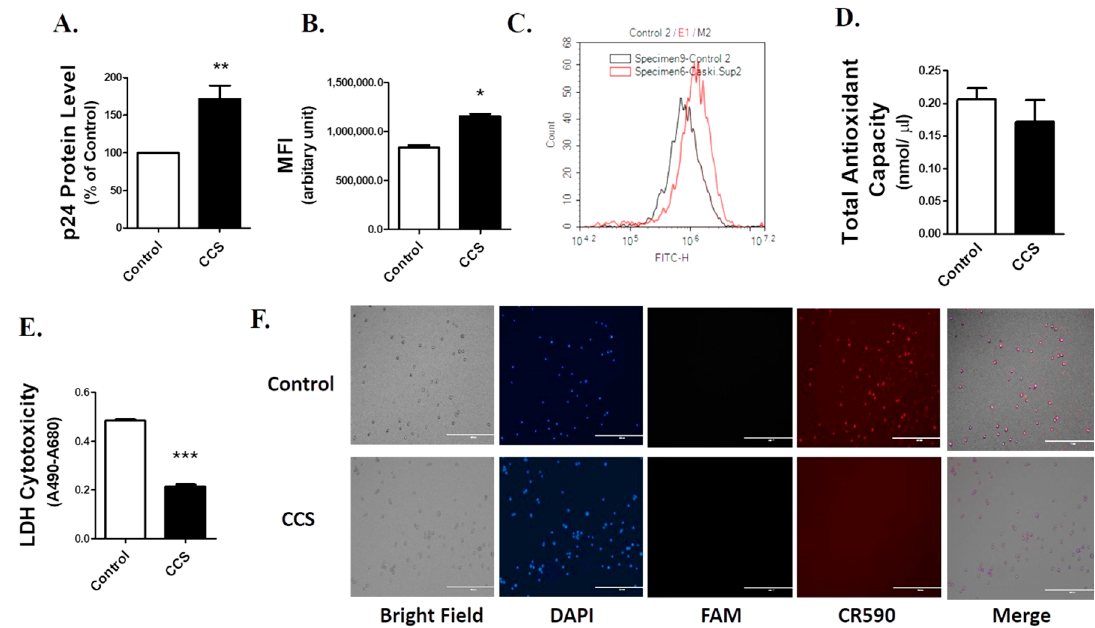
Figure 1. Caski cell culture supernatant (CCS) increases human immunodeficiency virus (HIV)-1 replication and oxidative stress in di ff erentiated U1 cell line. ( A ) Di ff erentiated U1 cell line was treated with 250 µ L of CCS every 24 h for 4 days. p24 ELISA was performed on the supernatant obtained from the treatment to measure the viral load. To minimize high standard deviation of the mean due to variability in absorbance values in di ff erent experiments, we converted the control absorbance values to 100% and normalized the values of treated groups to % of the control. ( B ) Reactive oxygen species (ROS) was measured in di ff erentiated U1 cell line after 4 days exposure of CCS. The treated cells were incubated with 2 (cid:48) ,7 (cid:48) - dichlorodihydrofluorescein diacetate (H2DCFDA), the fluorescence of which was monitored at maximum excitation and emission spectra of 495 nm and 529 nm, respectively, using flow cytometry. ( C ) Shows the graphical representation of ROS increase in CCS-treated U1 cells (red graph) versus control cells (grey graph). X-axis represents mean fluorescence intensity (MFI), showing ROS level. ( D ) Total antioxidant capacity of the cells was measured in CCS-treated cells using the Total Antioxidant Capacity Assay Kit. The values on the Y-axis represents the total amount of reduced Cu + in nmol / µ L, which quantitatively gives the measure of antioxidant capacity of the cells. ( E) Cytotoxicity after CCS exposure was measured using the Pierce TM LDH cytotoxicity assay kit. The values on the Y-axis represent the absorbance values of formazan dye at 490 nm, which gives the measure of cytotoxicity. The mean absorbance is obtained by subtracting the background absorbance at 680 nm. All the data were obtained from the mean of at least three independent experiments with the error bars representing standard error of mean. Significant di ff erence was considered at p < 0.05. *, **, *** represent p < 0.05, p < 0.005, and p < 0.0005, respectively. ( F ) Apoptotic DNA damage was examined using Apoptag ® Iso Dual Fluorescence Apoptosis Detection Kit. 4 (cid:48) ,6-diamidino-2-phenylindole (DAPI), Fluorescein amidite (FAM), and CR590 dyes were used to stain the nucleus, DNase Type II and I of DNA breaks,